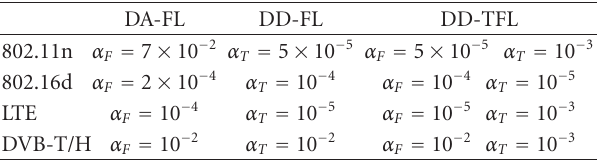
Table 2: Optimal loop